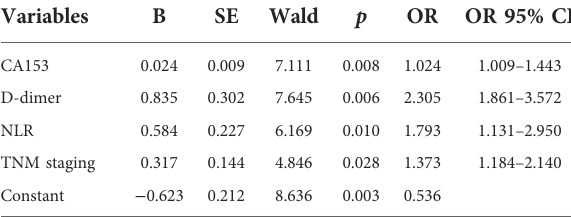
TABLE 6 Multivariate analysis of risk factors for recurrence and metastasis in breast cancer patients.